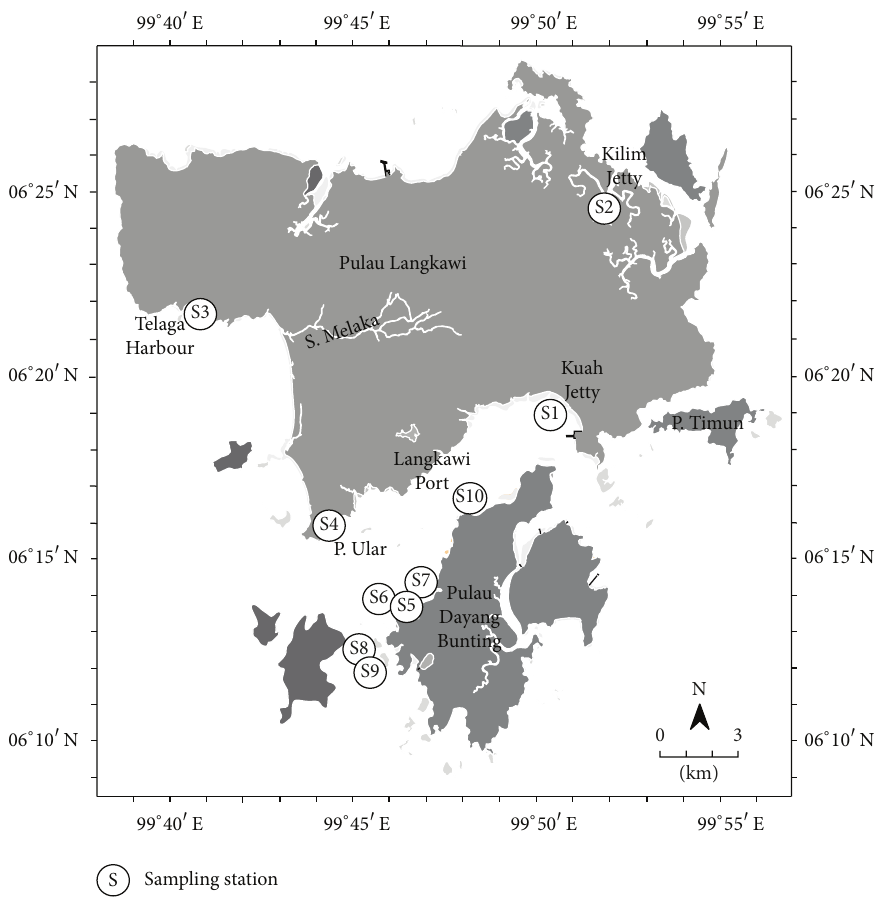
Figure 1: Map showing the ten sampling stations (S1 to S10) around Langkawi Island, Malaysia.